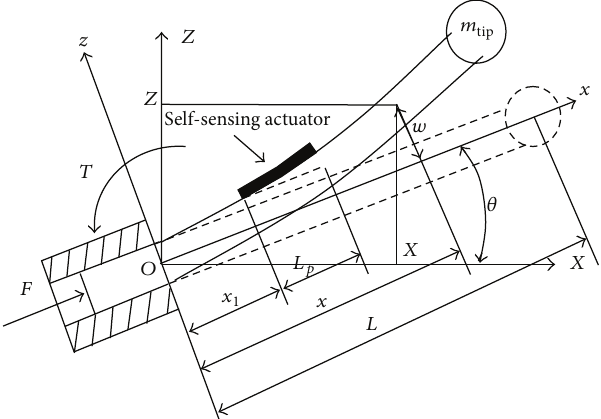
Figure 1: An axially translating robot arm with rotating-prismatic